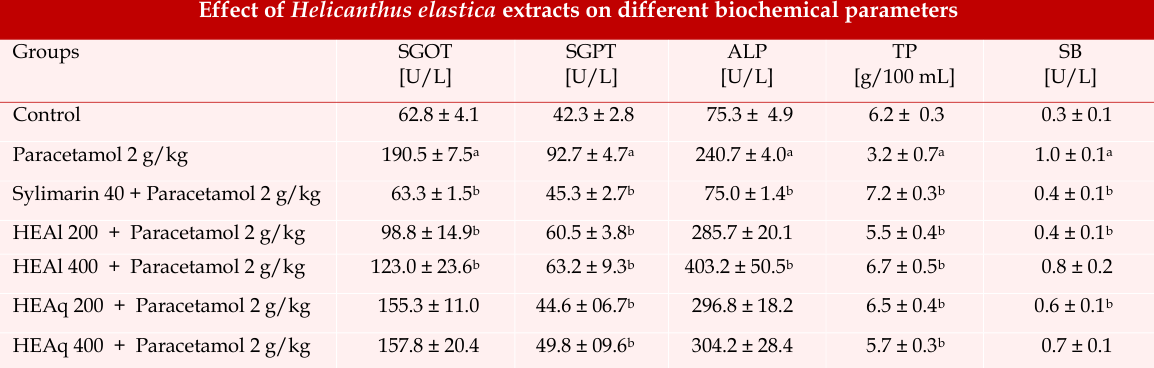
Effect of Helicanthus elastica extracts on different biochemical parameters Groups